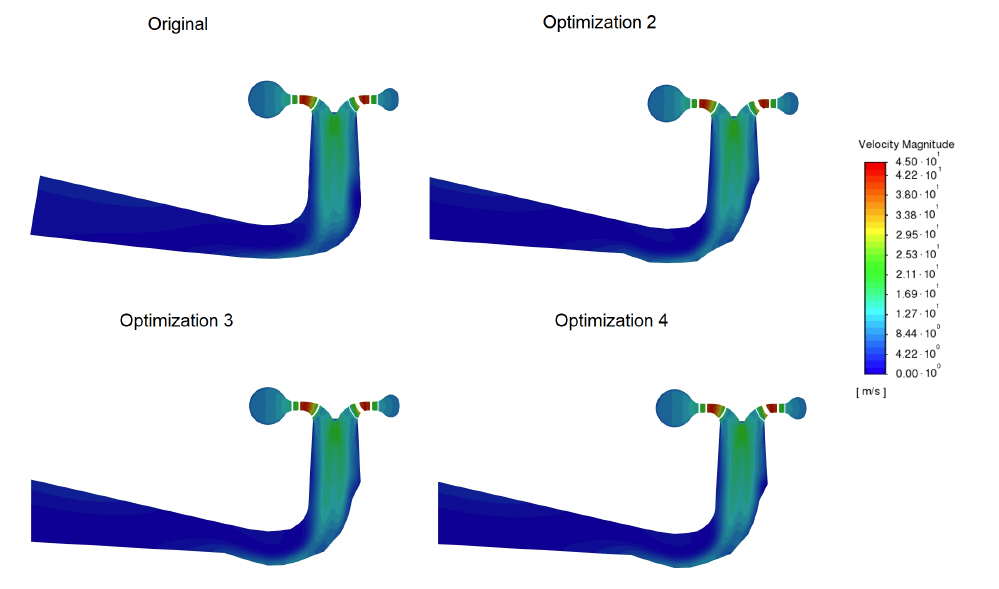
Figure A4. Velocity magnitudes in a longitudinal draft tube cross-section for a 10 m 3 /s flow rate.